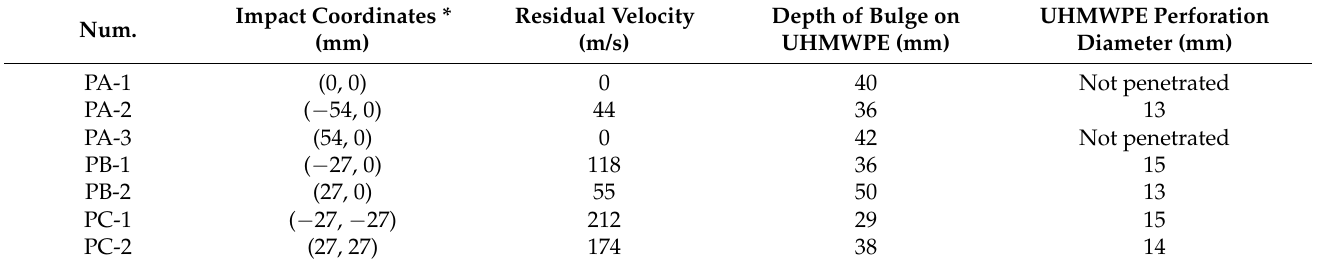
* Coordinate defined as in Table 2. Incident velocity is 650 m/s for all targets.